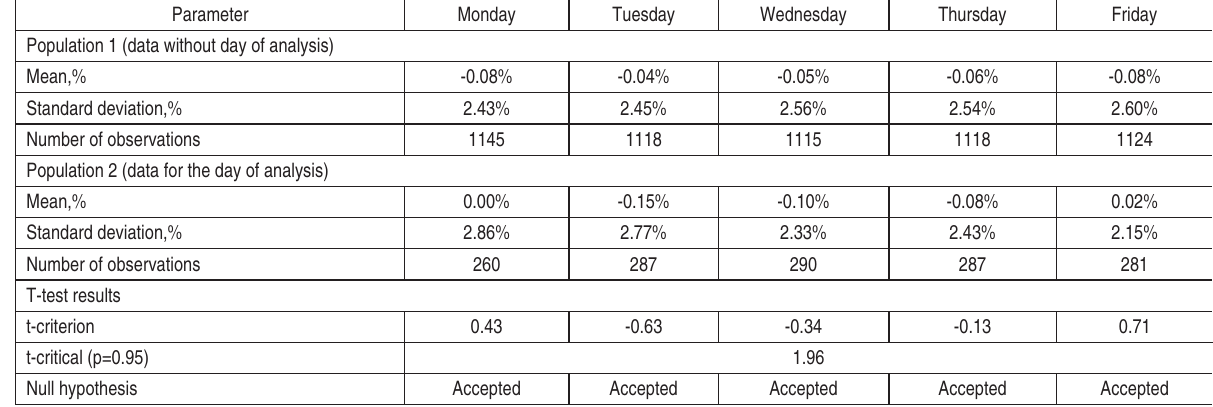
Table B2. T-test of the day-of-the-week effect for UX index